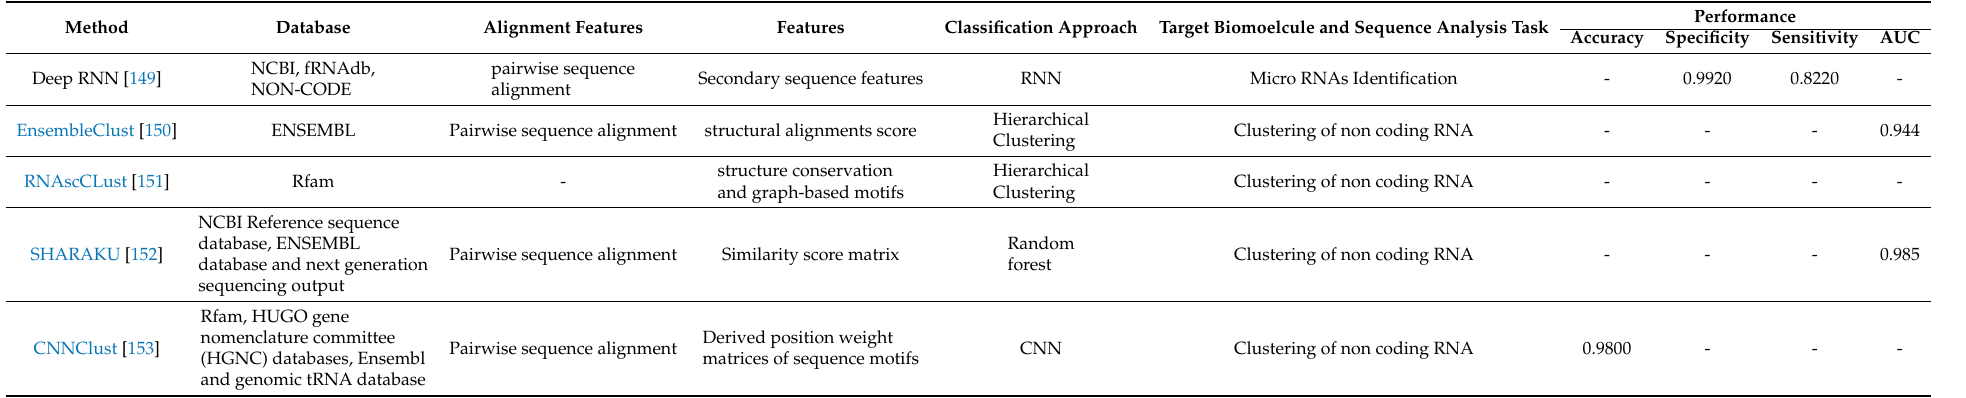
Table 5. Summary of machine and deep learning based methodologies proposed for the identification and clustering of non-coding